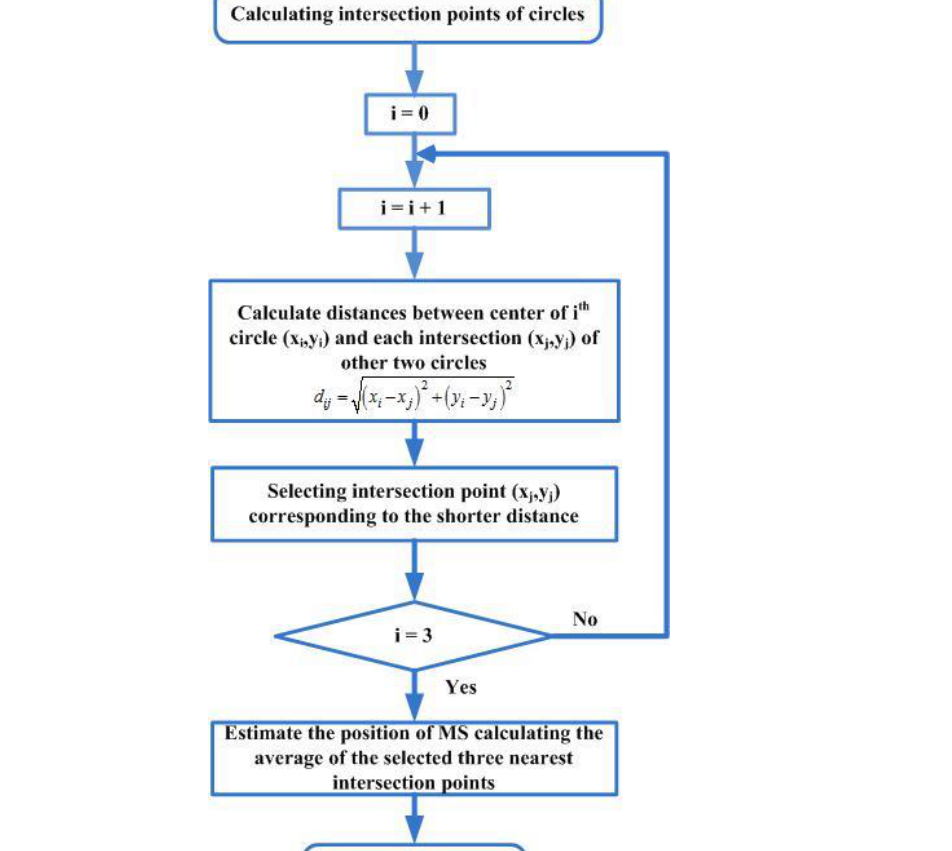
7 of 19 Table 1. Summary of the shortest distance algorithm. 1.